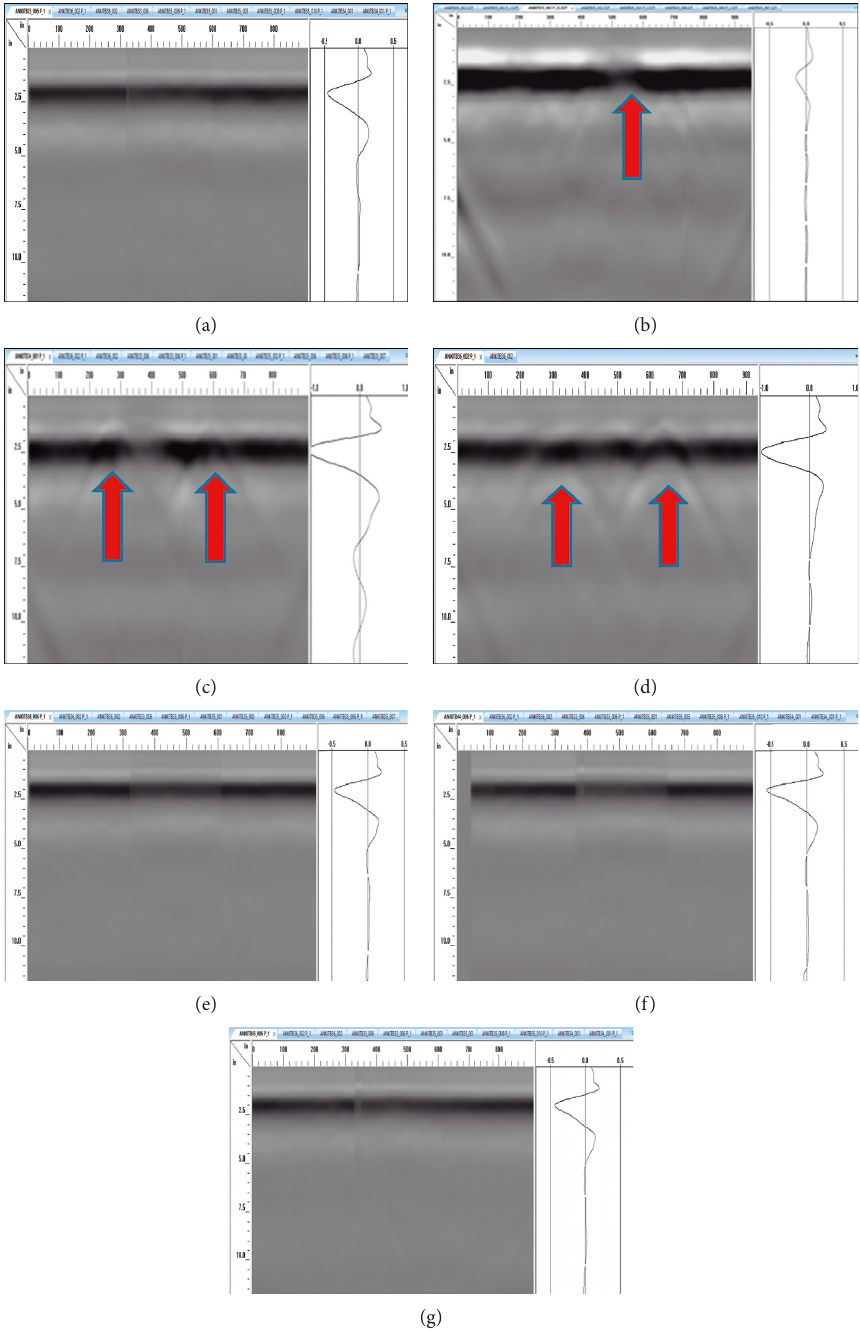
Figure 11: GPR scans. (a) Sample 1. (b) Sample 5. (c) Sample 4. (d) Sample 6. (e) Sample 7. (f) Sample 9. (g) Sample